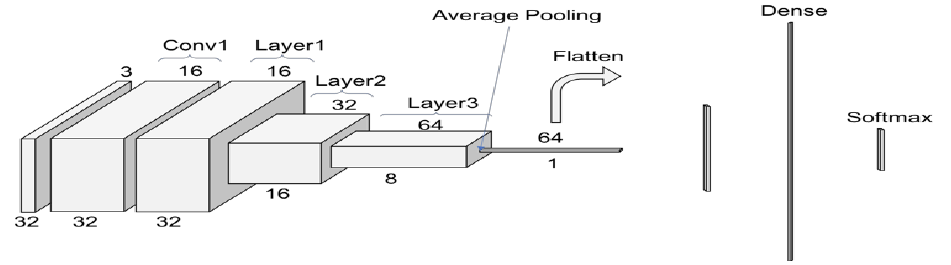
Figure 8. ResNet structure on CIFAR10.